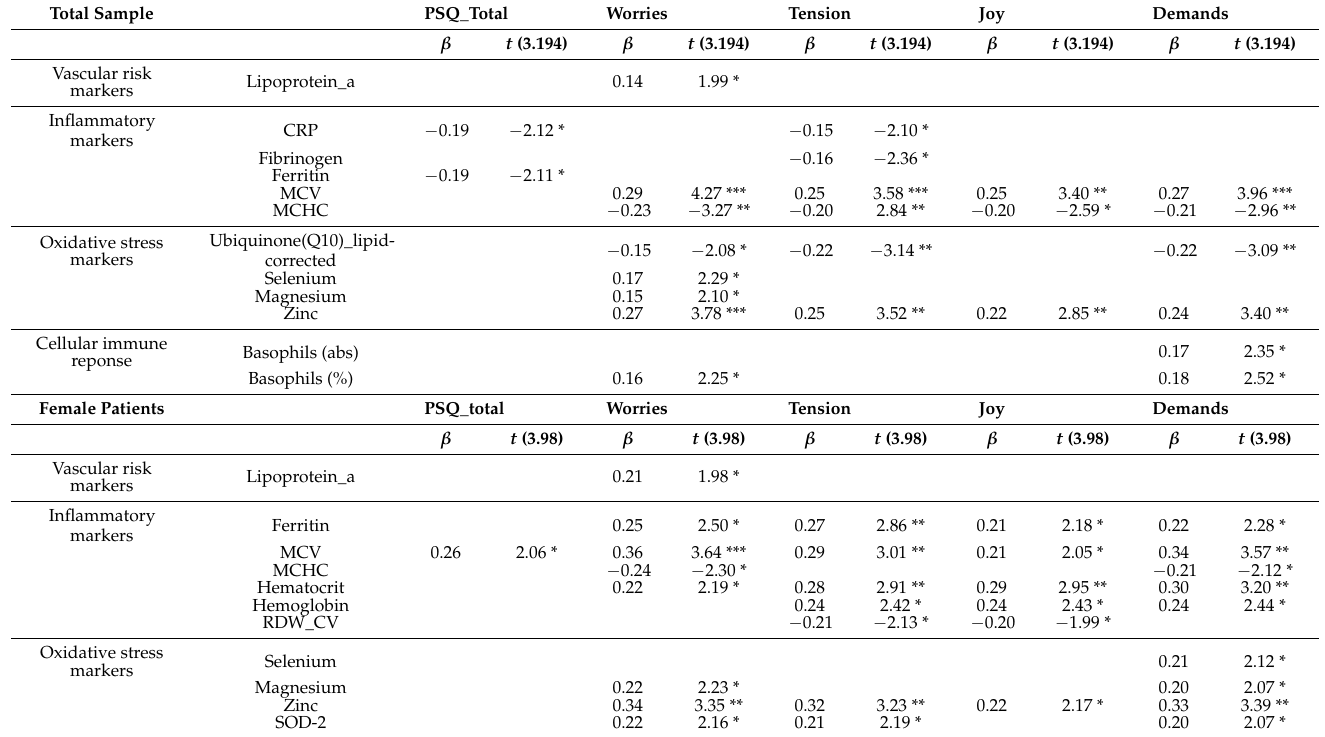
Table 6. Age- and tinnitus-related distress-adjusted univariate regression analyses with perceived stress indices being regressed on blood parameter values for the total sample, female patients, and male patients with chronic tinnitus. Only significant associations are reported (* = p < 0.05; ** = p < 0.01; *** = p <